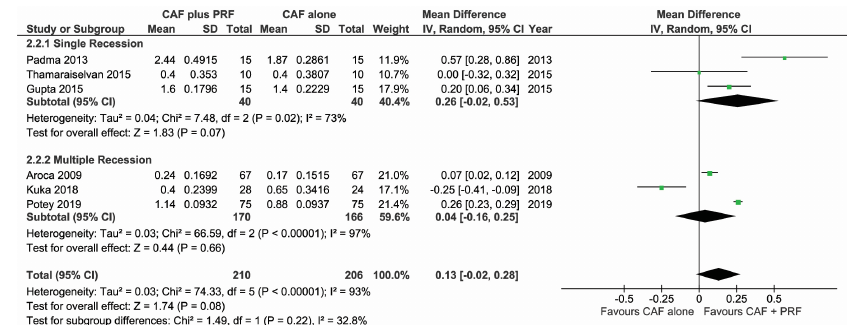
Figure 3. Comparison of change in width of keratinized gingiva (WKG) between CAF + L-PRF versus CAF alone with 6–12 months follow-up.